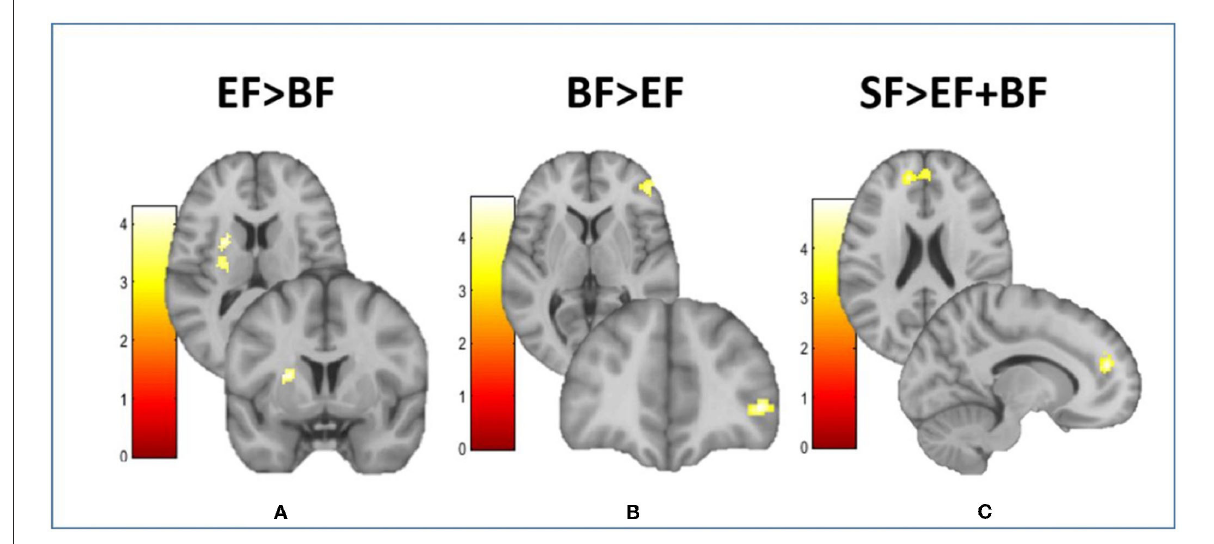
FIGURE2 Differences between groups in the resting-state functional connectivity of the medial hypothalamus. This figure shows different brain images of the medial hypothalamus. Color bars represent the connectivity intensity value or t-value. (A) EF > BF: MH-putamen extending to insula; (B) BF